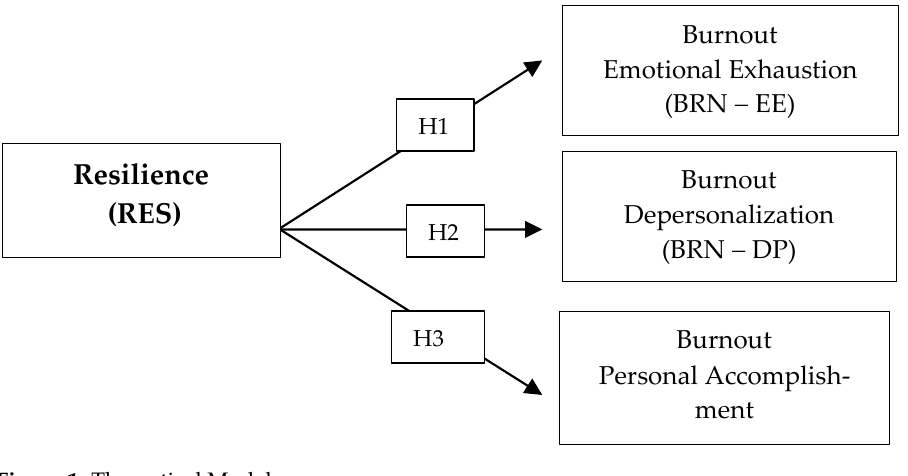
Figure 1. Theoretical Model.